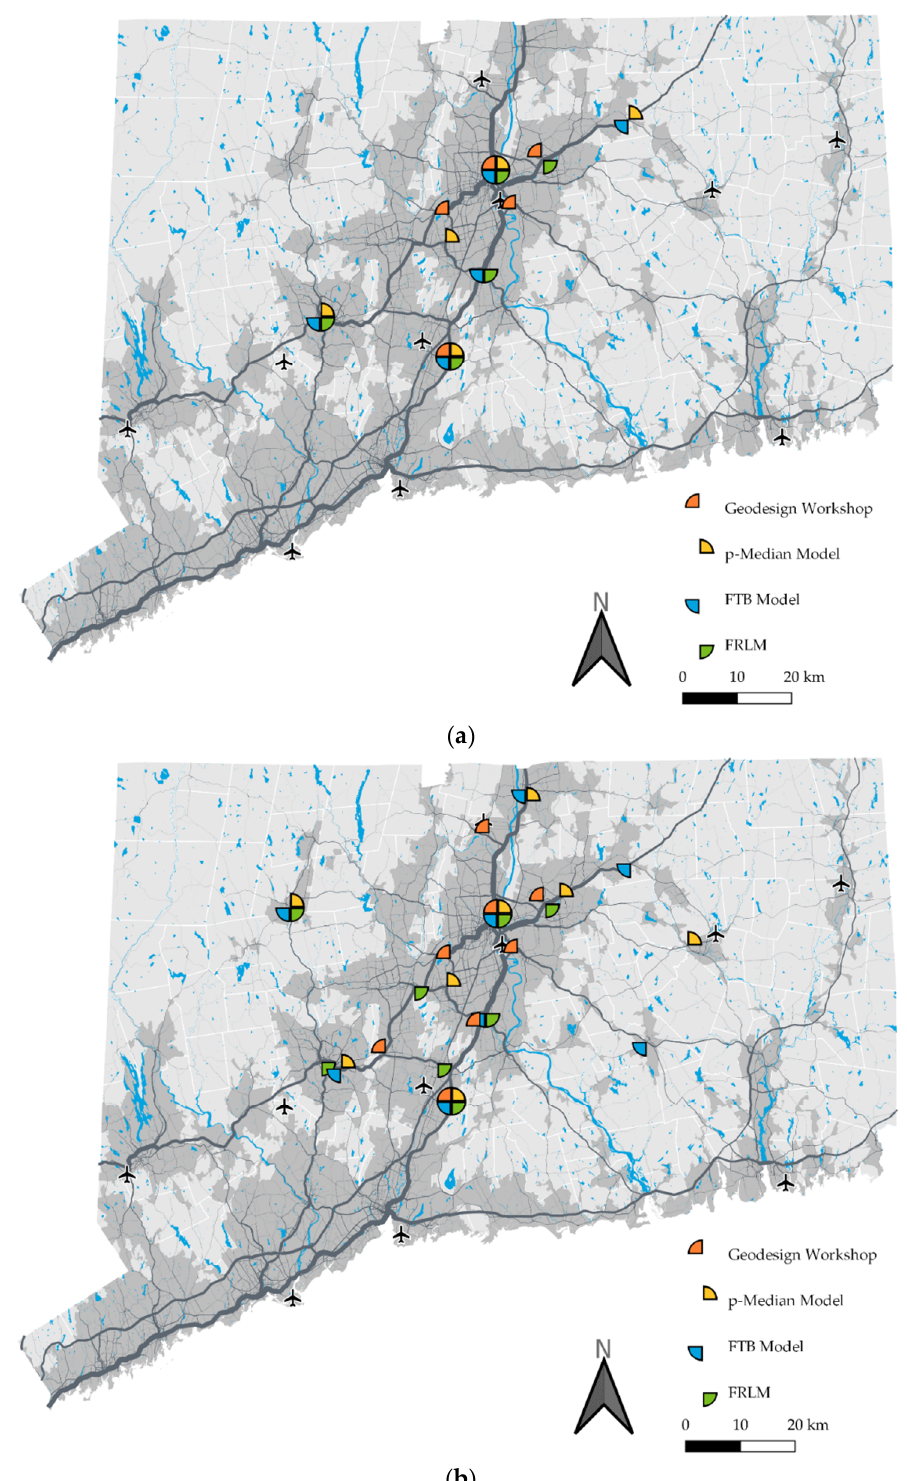
Figure 8. The HRS network designs generated by the geodesign workshop, the p-median model, the FTB model, and the FRLM for ( a ) 5 stations and ( b ) 8 stations. Geographically, the workshop results are more tightly clustered around the Hartford urban core than any optimization model results. This is particularly true for p = 5, in which all three workshop-recommended stations are close to downtown Hartford and the planned station north of downtown. In contrast, the p- median and FRLM models